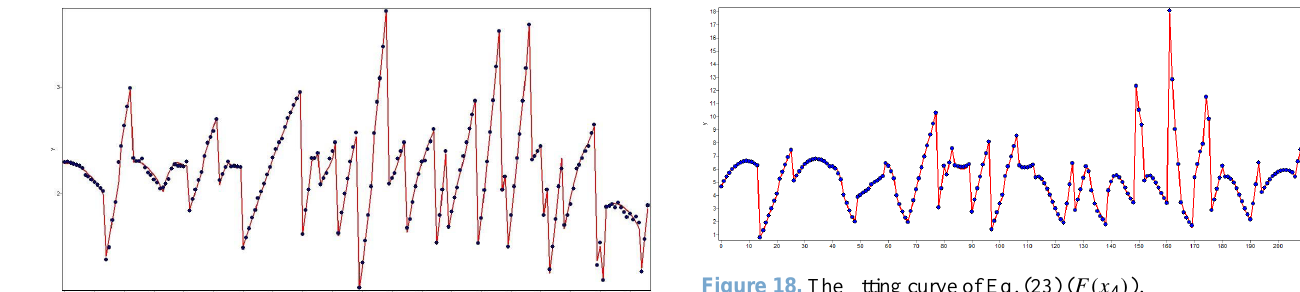
Figure 18. The fitting curve of Eq. (23) ( F(x 4 ) ).